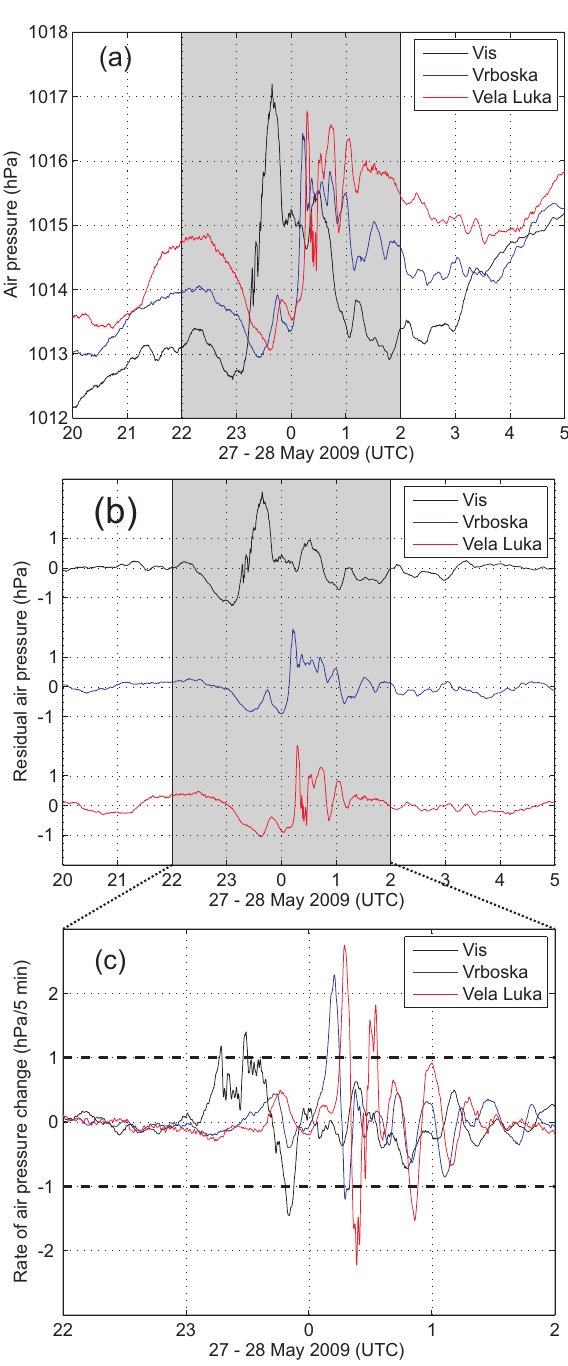
Fig. 4. Same as Fig. 3, but for the 27–28 May 2009